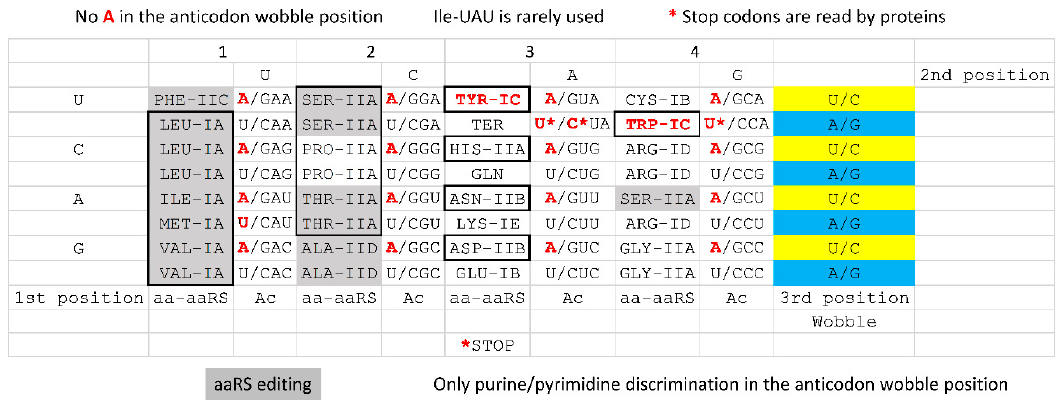
Figure 13. Aminoacyl-tRNA synthetases (aaRS) evolution (mostly) in Pyrococcus furiosis (Pfu) , an ancient archaea. Columns of the genetic code are indicated by shading: column 1 (red); column 2 (yellow); column 3 (blue); and column 4 (green). Class I and class II aaRS enzymes are indicated with their structural subclasses (A–E). aaRS enzymes with editing active sites are in green type. Boxes are placed around class I aaRS enzymes. Sma: Staphylothermus marinus; Eco: Escherichia coli . AlaX is an editing function missing a synthetic AlaRS active site. This figure is modified from [46].